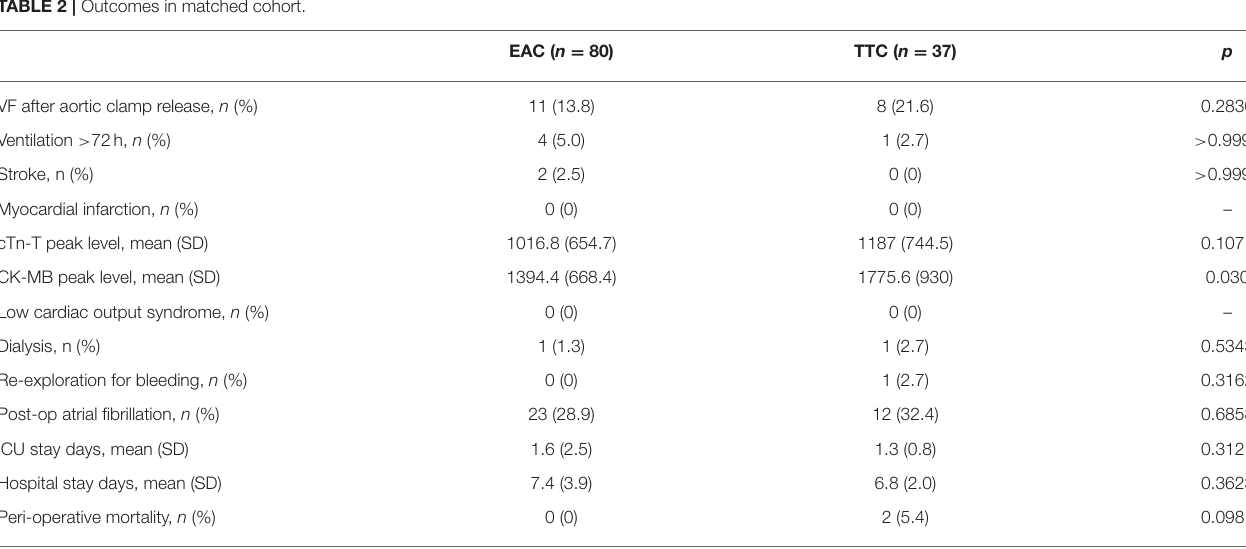
TABLE 2 | Outcomes in matched